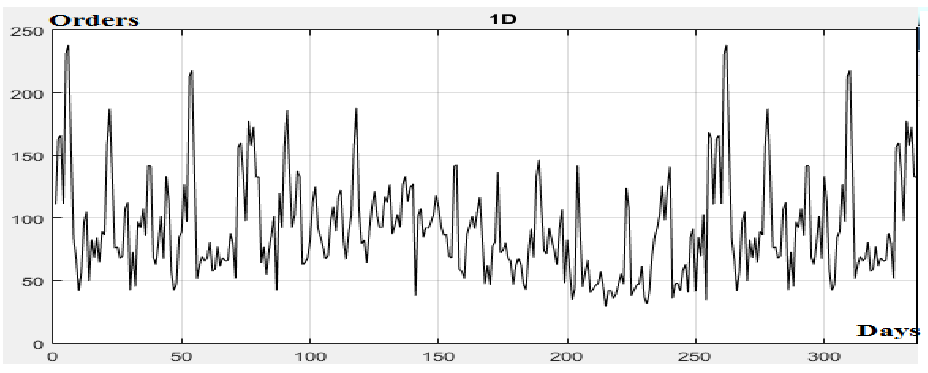
Fig. 1 Distribution of orders by day of the